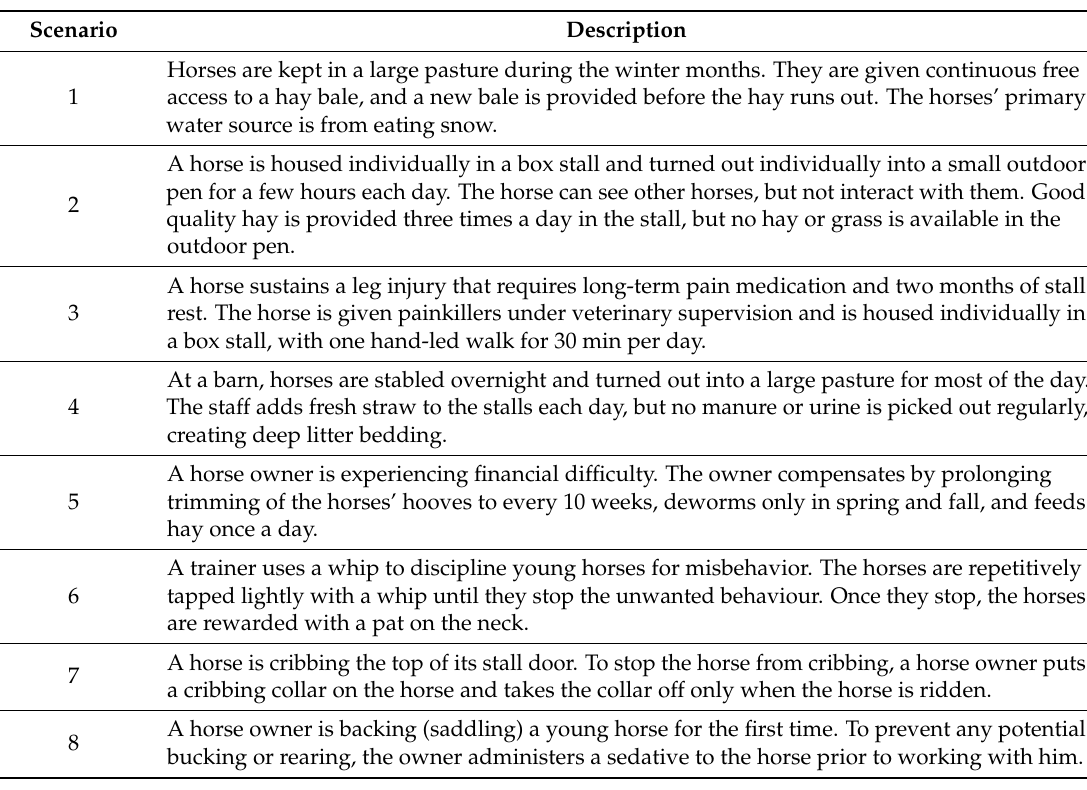
Table 1. Description of the eight scenarios of potentially compromised horse welfare used to assess survey respondent thresholds of acceptable